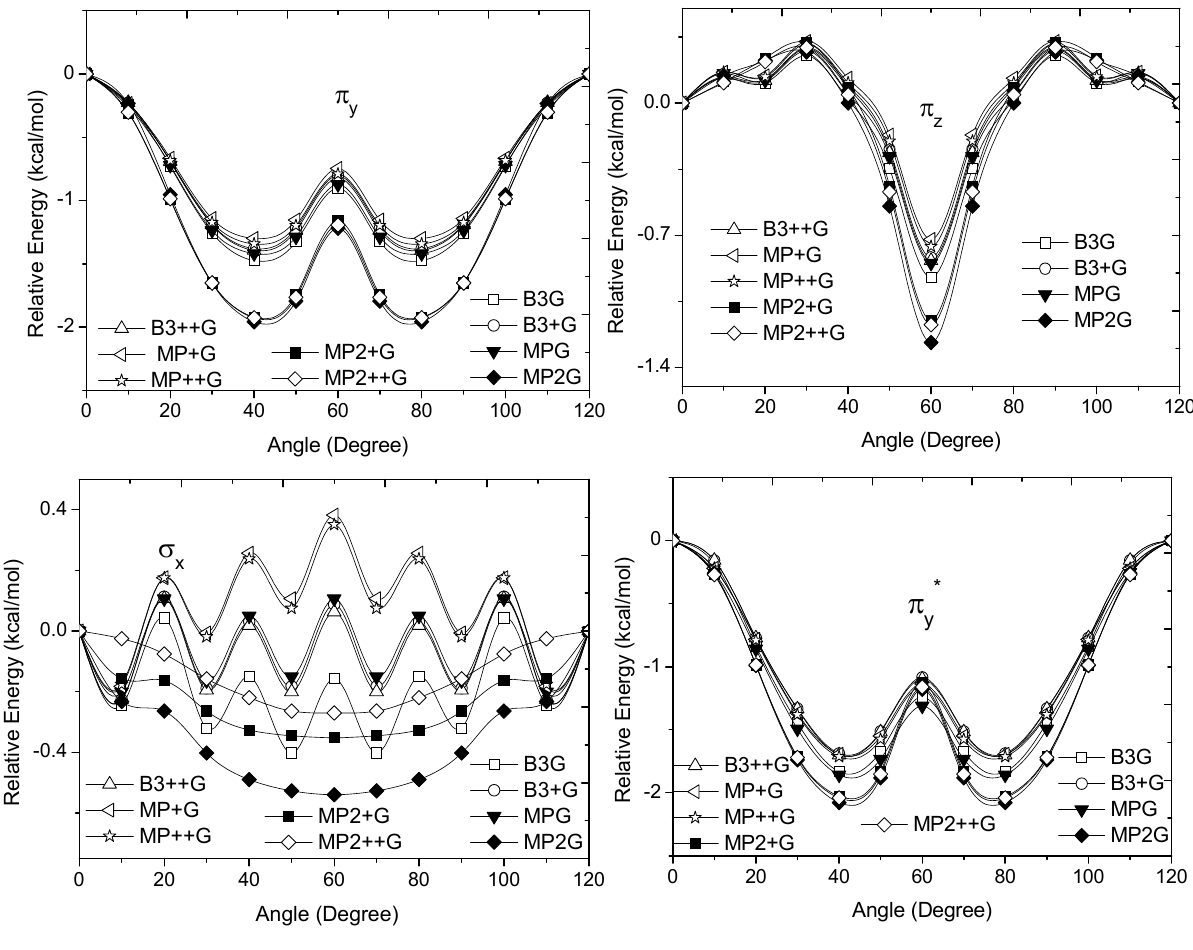
Figure 3. Energy of the π , π , σ and occupy MOs of ethane as a function of the v z x rotational angle, calculated with the entire theoretical model studied in this work. Labels B3, MP correspond to the B3LYP, and mPWB95 functionals, MP2 correspond to the HF theory and the symbols G, +G and ++G represent the basis set 6-31G(d, p), 6-31+G(d, p), and 6-31++G(d, p),